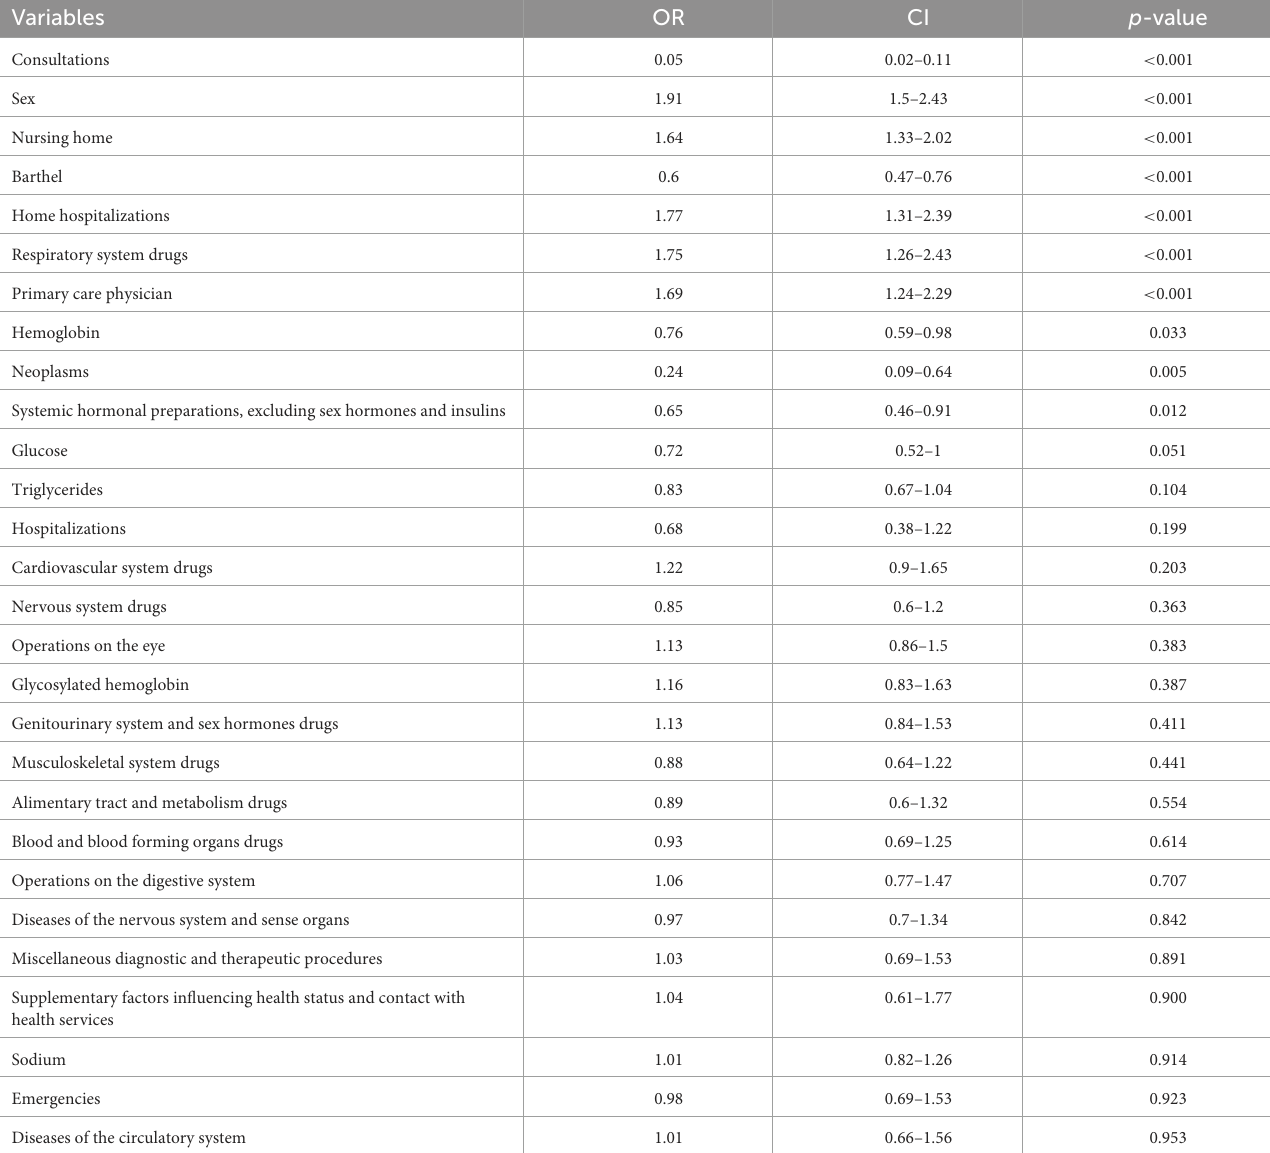
TABLE 7 Results from logistic regression model. OR, CI (95%), and p -values, sorted by p -value.